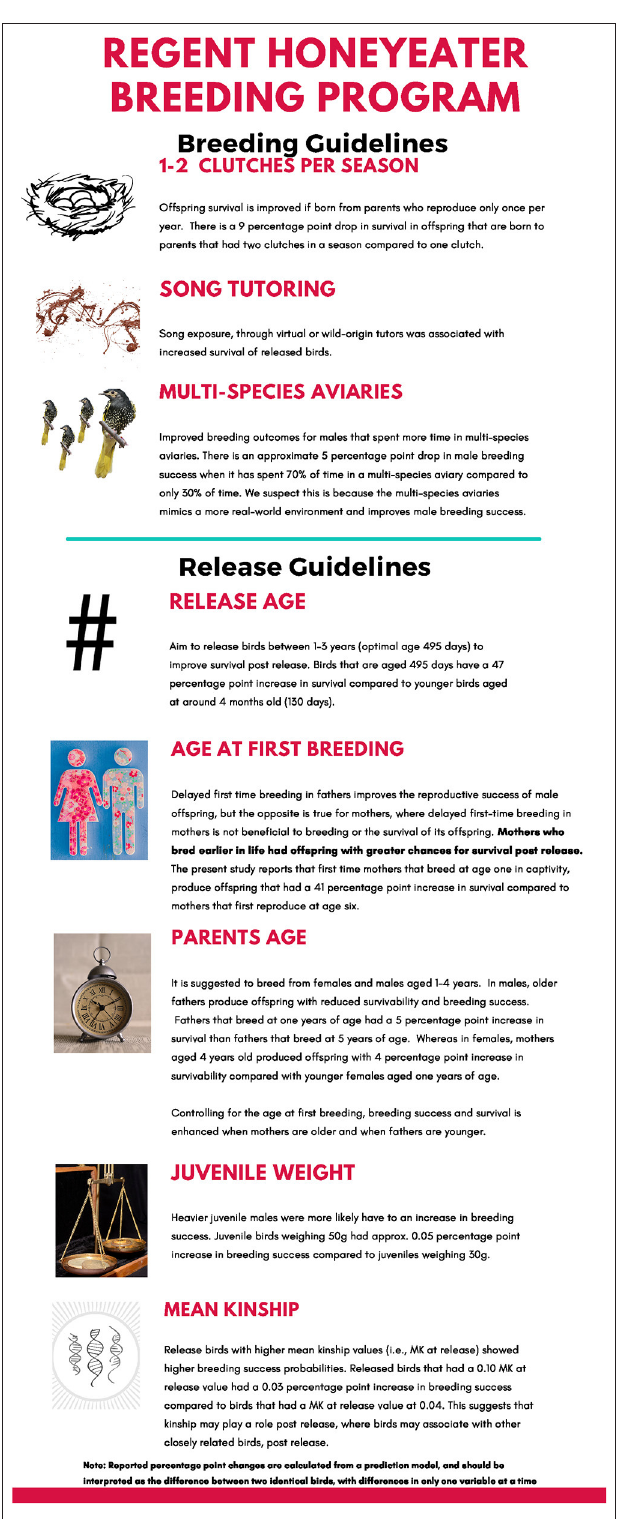
FIGURE 5 | Breeding and release guidelines developed as part of the review of the zoo life experiences for Regent